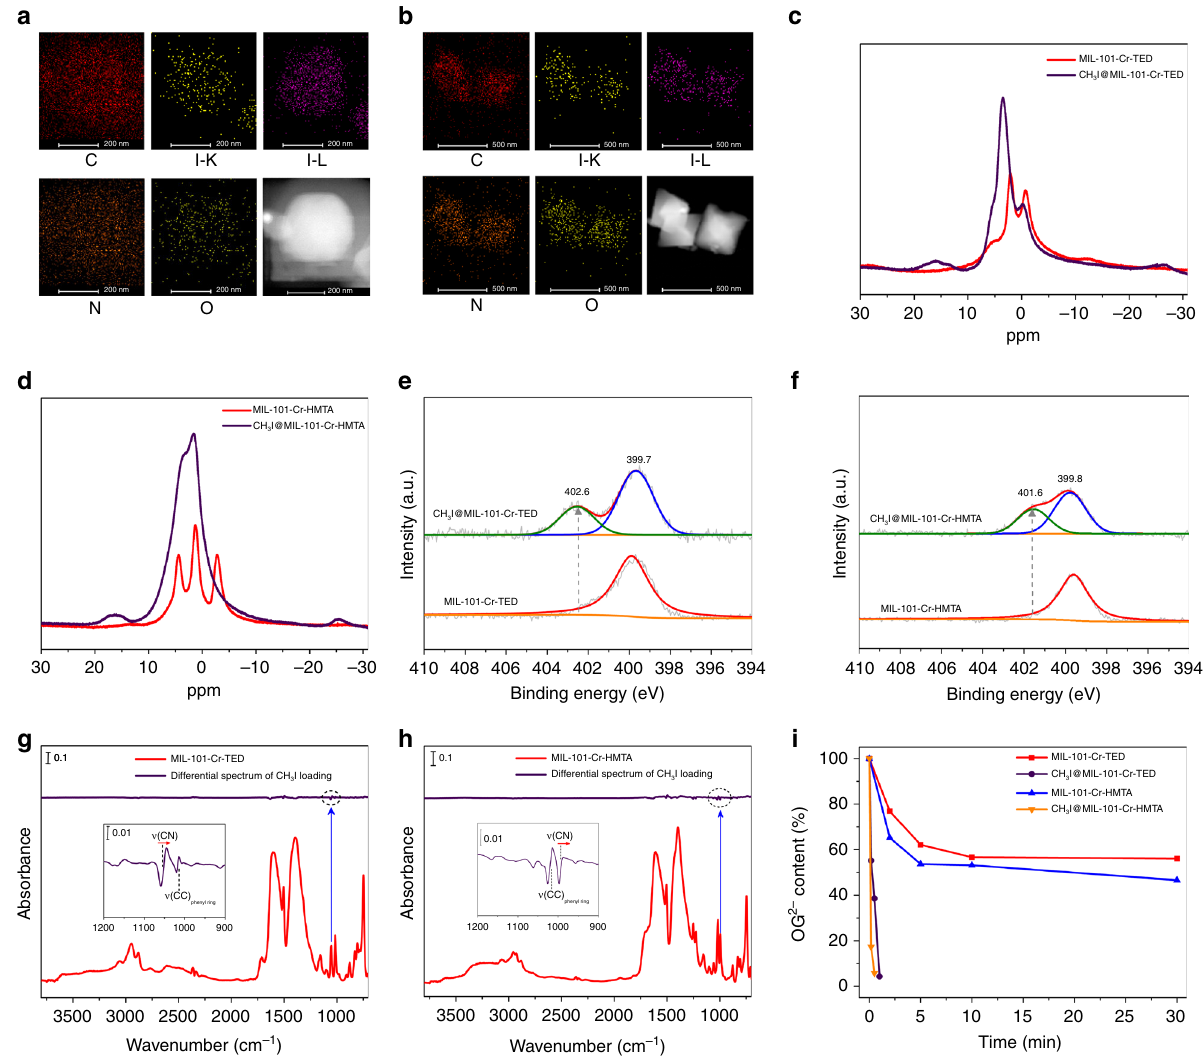
Fig. 4 The mechanism of CH 3 I capture by MIL-101-Cr-TED and MIL-101-Cr-HMTA. a The elemental mapping of CH 3 I loaded MIL-101-Cr-TED. b The elemental mapping of CH 3 I loaded MIL-101-Cr-HMTA. c Solid 1 H NMR spectra of MIL-101-Cr-TED and CH 3 I@MIL-101-Cr-TED. d Solid 1 H NMR spectra of MIL-101-Cr-HMTA and CH 3 I@MIL-101-Cr-HMTA. e XPS spectra of N(1s) for MIL-101-Cr-TED and CH 3 I@MIL-101-Cr-TED ( gray , experiment curves; red , blue , and green : fi tted curves; orange : baselines). f XPS spectra of N(1s) for MIL-101-Cr-HMTA and CH 3 I@MIL-101-Cr-HMTA ( gray , experiment curves; red , blue , and green : fi tted curves; orange : baselines). g In situ IR spectra ( green ) of ~150 Torr CH 3 I exposed MIL-101-Cr-TED referenced to the activated MIL-101-Cr-TED; and IR absorption spectra ( red ) of activated MIL-101-Cr-TED referenced to KBr pellet in vacuum ( < 20 mtorr). h In situ IR spectra ( green ) of ~150 Torr CH 3 I exposed MIL-101-Cr-HMTA referenced to the activated MIL-101-Cr-HMTA; and IR absorption spectra ( red ) of activated MIL-101-Cr-HMTA referenced to KBr pellet ( < 20 mtorr). i Ion exchange ef fi ciencies of an anionic dye (Orange G or OG) by pristine MIL-101-Cr-TED and MIL-101-Cr-HMTA and functionalized CH 3 I@MIL-101-Cr-TED and CH 3 I@MIL-101-Cr-HMTA as a function of